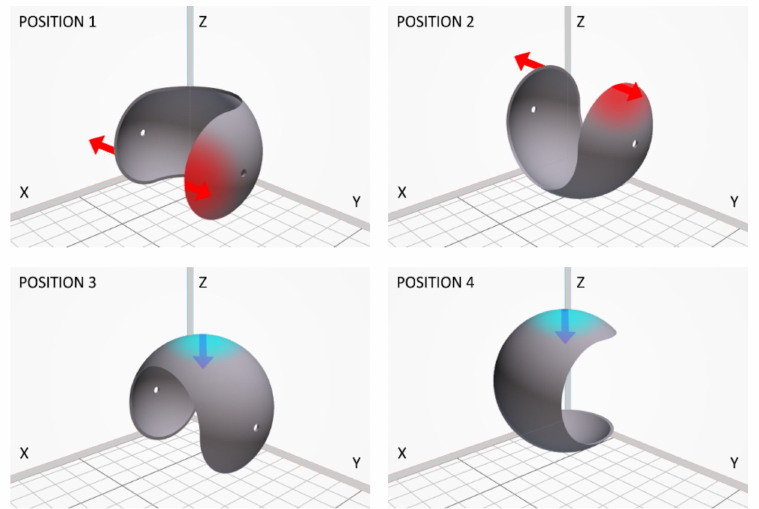
Figure 13. Graphical summary of the 3D scanning investigations for all print